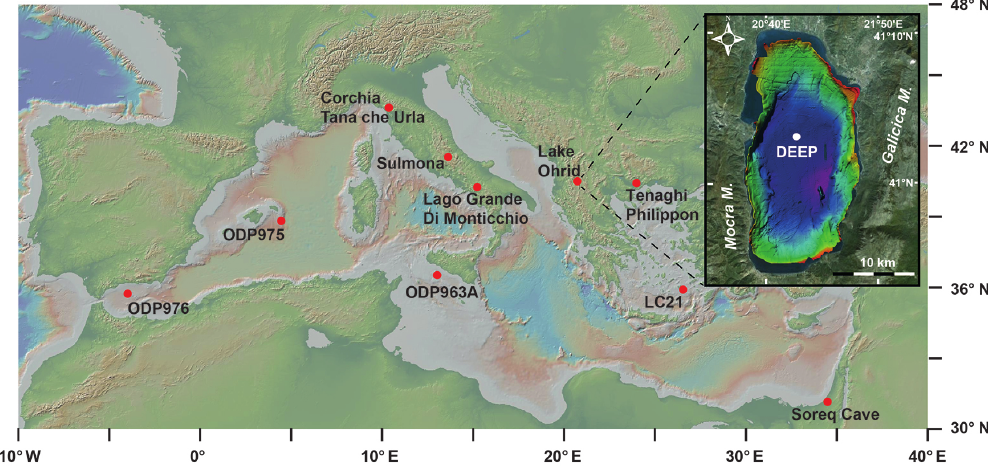
Figure 1. (a) site quoted in the text; (b) DEEP site drilling location within Lake Ohrid.